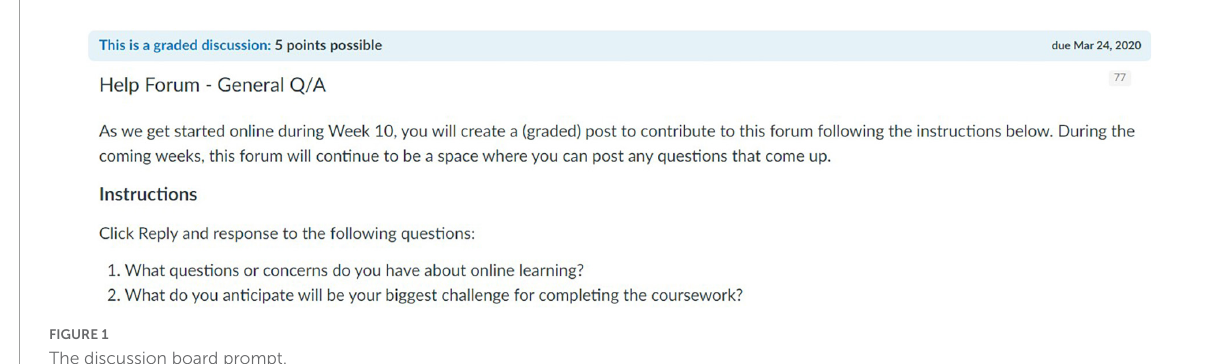
FIGURE1 The discussion board